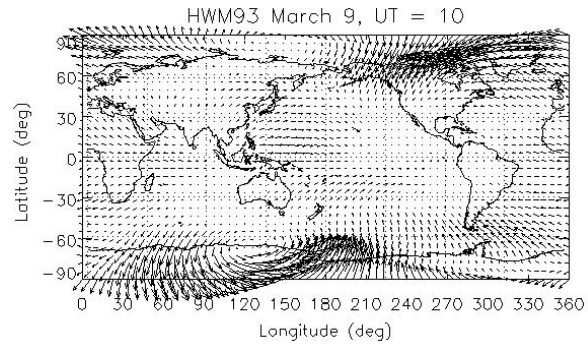
Fig. 10. Global pattern of the horizontal neutral wind derived from HWM-93 at 400km altitude and 10:00 UT (30 ◦ and 210 ◦ longi- tudes are noon and midnight, respectively) on 9 March in the con- dition of F 10 . 7 =125 and Ap =21. The maximum arrow indicates the wind velocity of 359m/s.